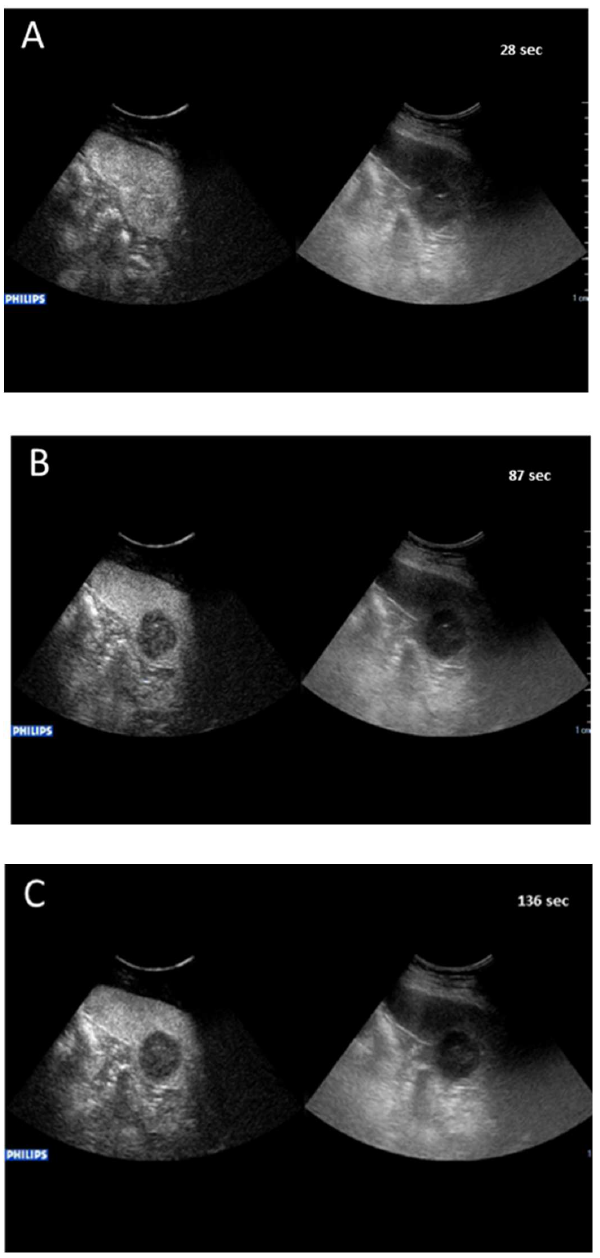
Figure 2. Major features of CEUS according to the exploratory diagnostic criteria. ( A – C ) showing aggressive non-Hodgkin lymphoma nodule with very marked wash-out, at 87 s from contrast agent injection. C-HL nodules showed isoenhancement in the arterial phase followed by early wash- out onset appearance and marked in degree between 90 and 110 s following contrast agent injection, in a total of 57/60 (95%) nodules (Figure 3). The 60 nodules of exploratory c-HL- DC had the onset of wash-out occurring at a median of 43 sec (range 25–48 s) with a me- dian of marked wash-out of 100 s (range 92–120 sec).